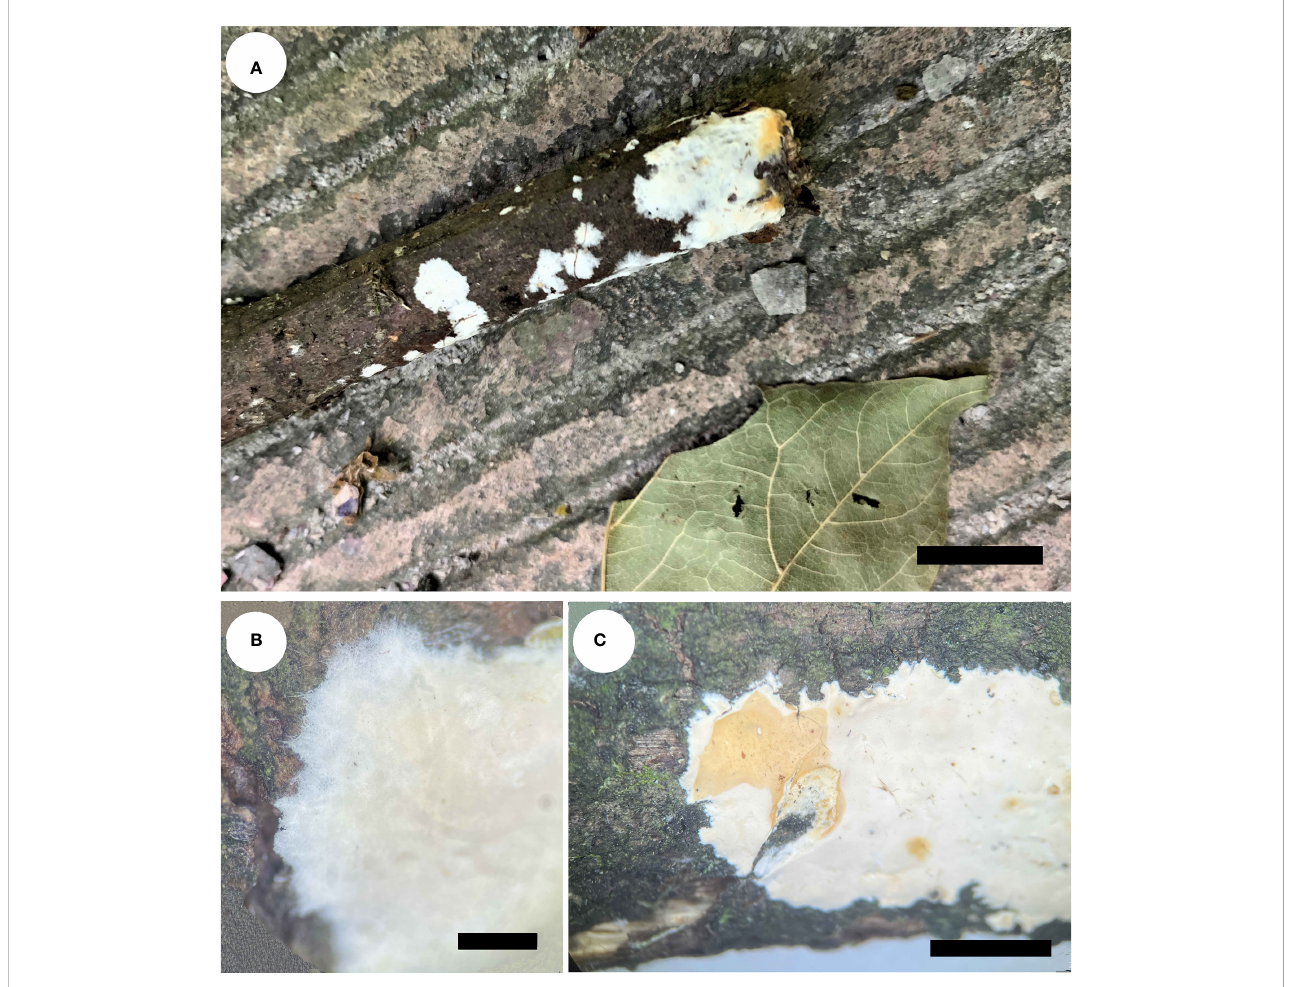
FIGURE 1 Basidiocarps of Phanerochaete shenghuaii (holotype, Dai 24610). (A) In situ . (B) Detailed view of the margin. (C) Reaction with KOH. Scale bars: (A) = 1 cm, (B) = 2 mm, (C) = 0.5